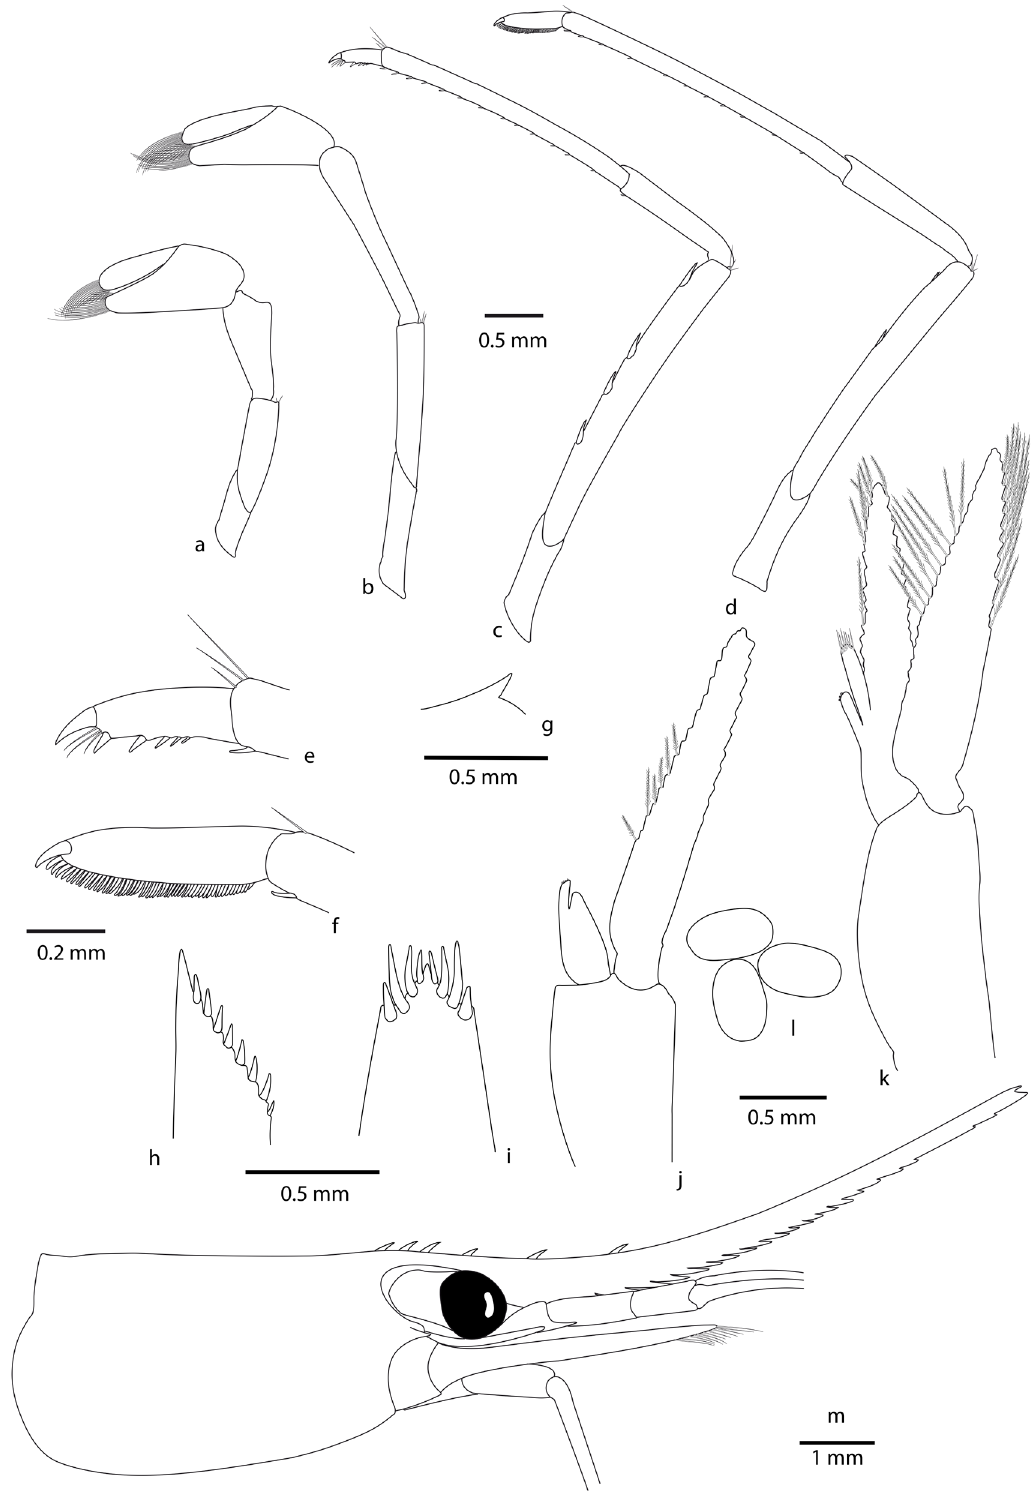
Fig. 5. Caridina neglecta Cai & Ng, 2007. a . First pereiopod. b . Second pereiopod. c . Third pereiopod. d . Fifth pereiopod. e . Dactylus of third pereiopod. f . Dactylus of fifth pereiopod. g . Pre-anal carina. h . Uropodal diaeresis. i . Telson. j . First male pleopod. k . Second male pleopod. l . Eggs. m . Cephalothorax. MNHN-IU-2018-2811 (a–i, l) and MNHN-IU-2018-2808 (j–k,